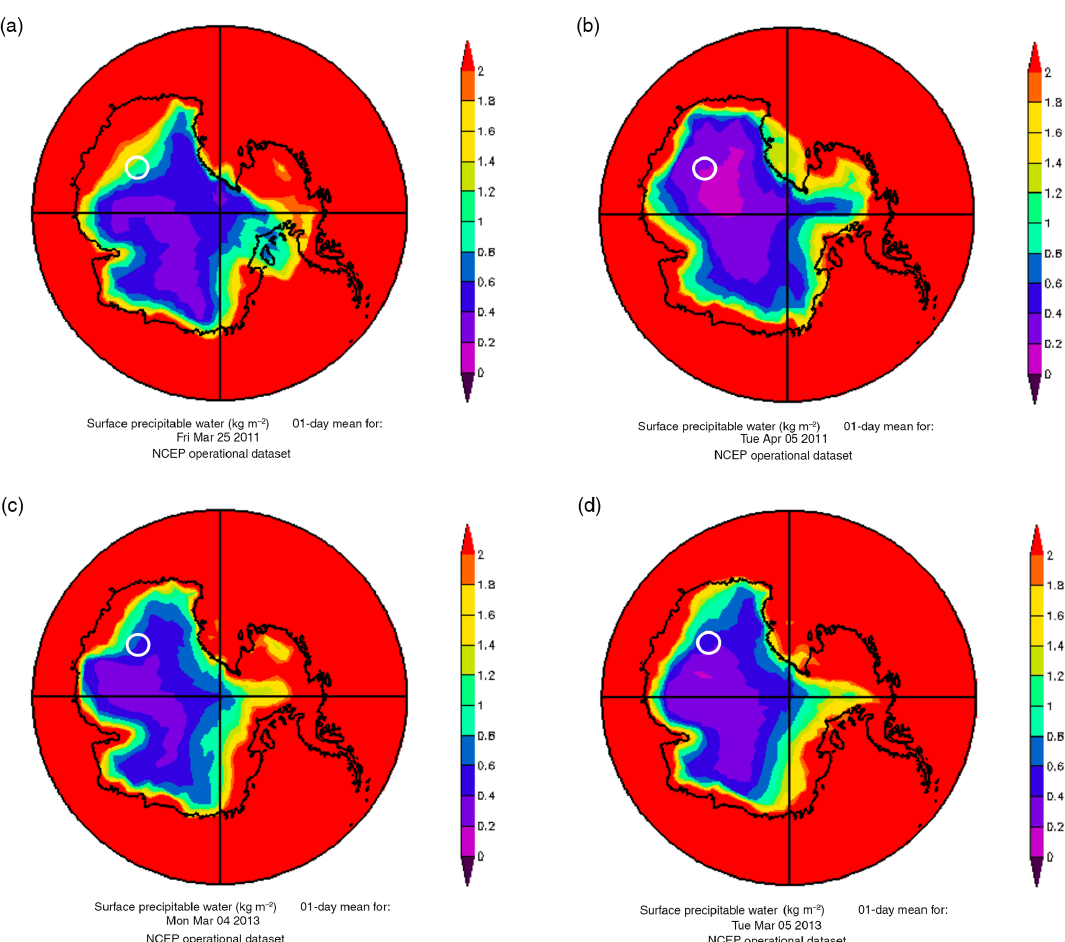
Figure 15. IWV calculated above the Antarctic continent from the NCEP/NCAR operational analyses on 25 March 2011 (a) , 5 April 2011 (b) , 4 March 2013 (c) and 5 March 2013 (d) . The white circle represents the position of the Dome C station.